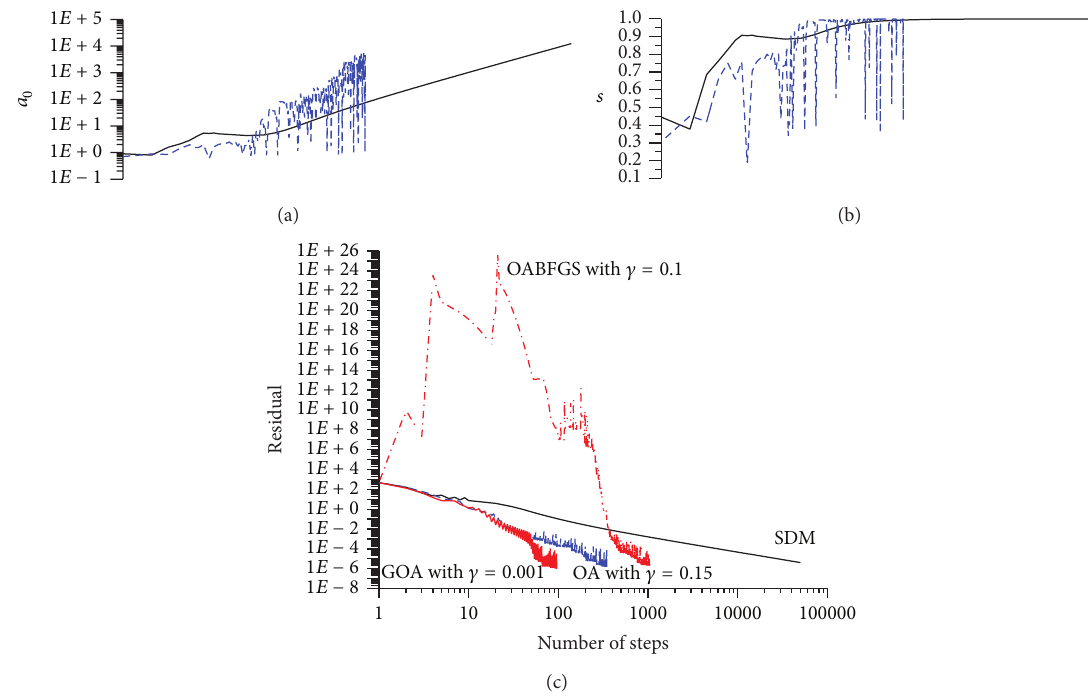
Figure 4: For the Powell problem, comparing (a) 𝑎 0 and (b) 𝑠 of SDM and OA and (c) the residuals obtained by the SDM, OA, GOA, and OABFGS.